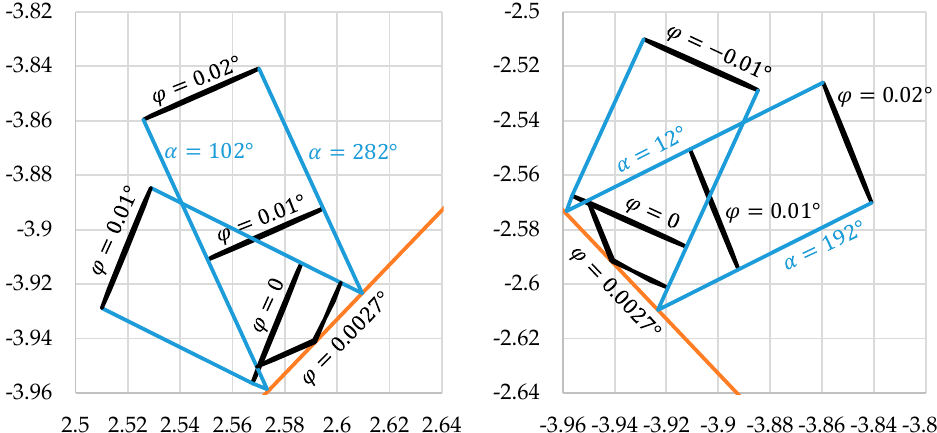
Figure 14. Bending ellipses (black) for different torsion angles 𝜑 with 𝛽 = 0.05° . Left: beam 1, right: beam 2. Dimensions are in mm .